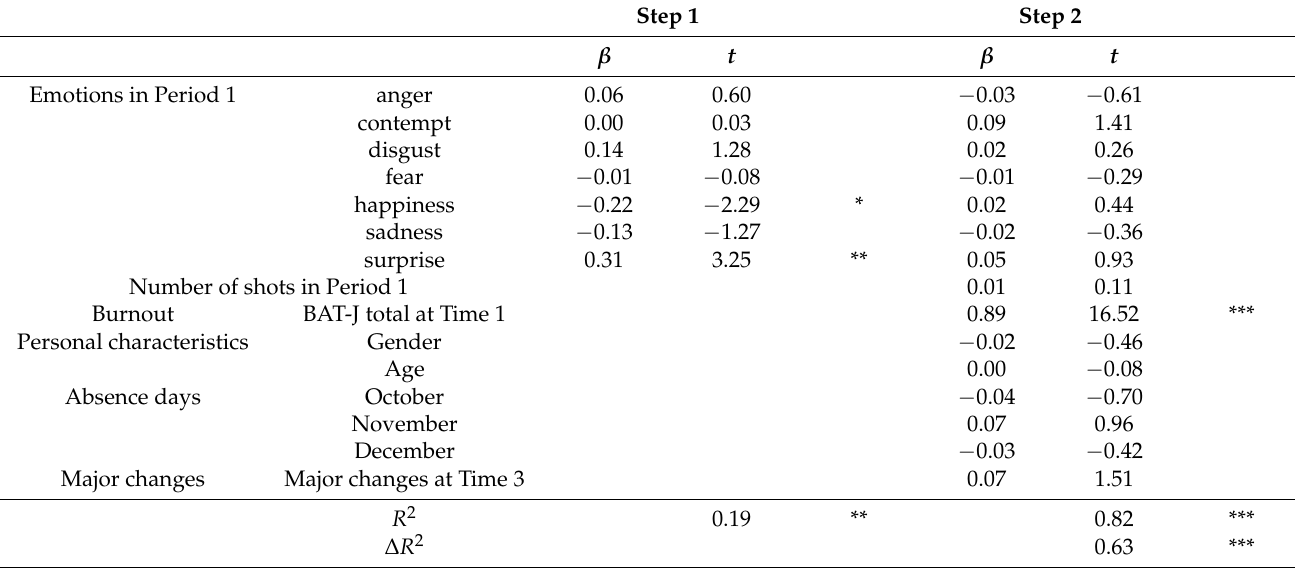
Table 6. Results of hierarchical multiple regression analysis for burnout at Time 3. Step 1 Step 2 β t β